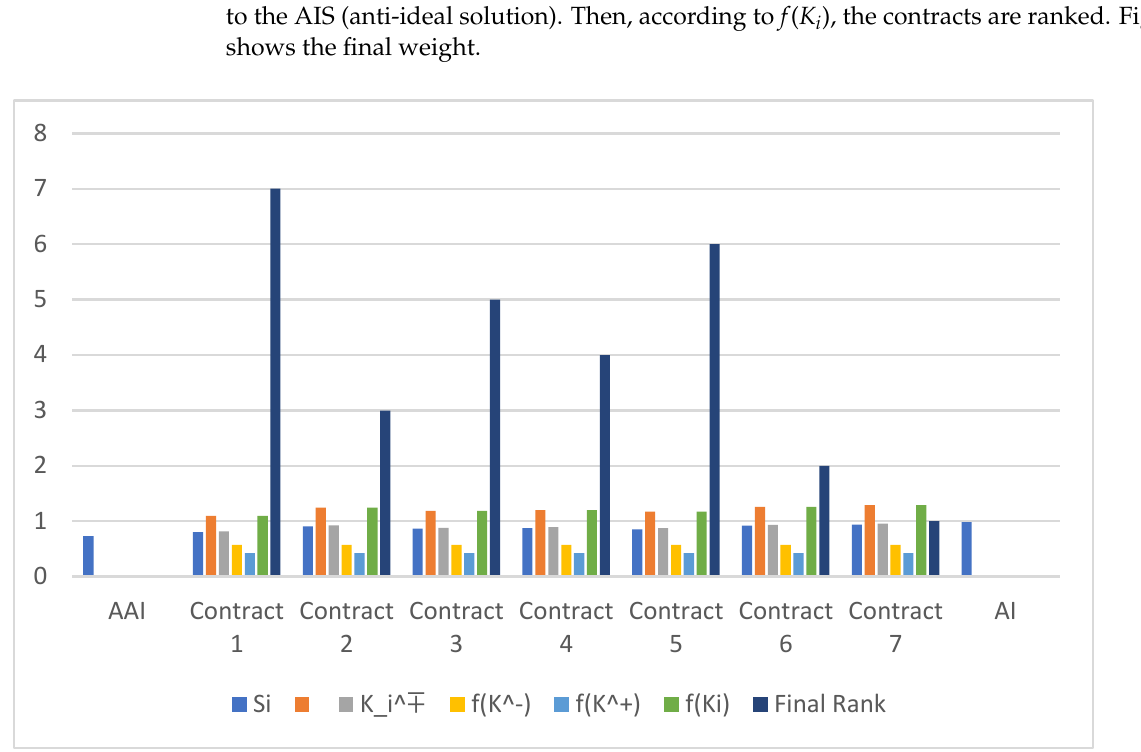
Figure 3. Final weight.